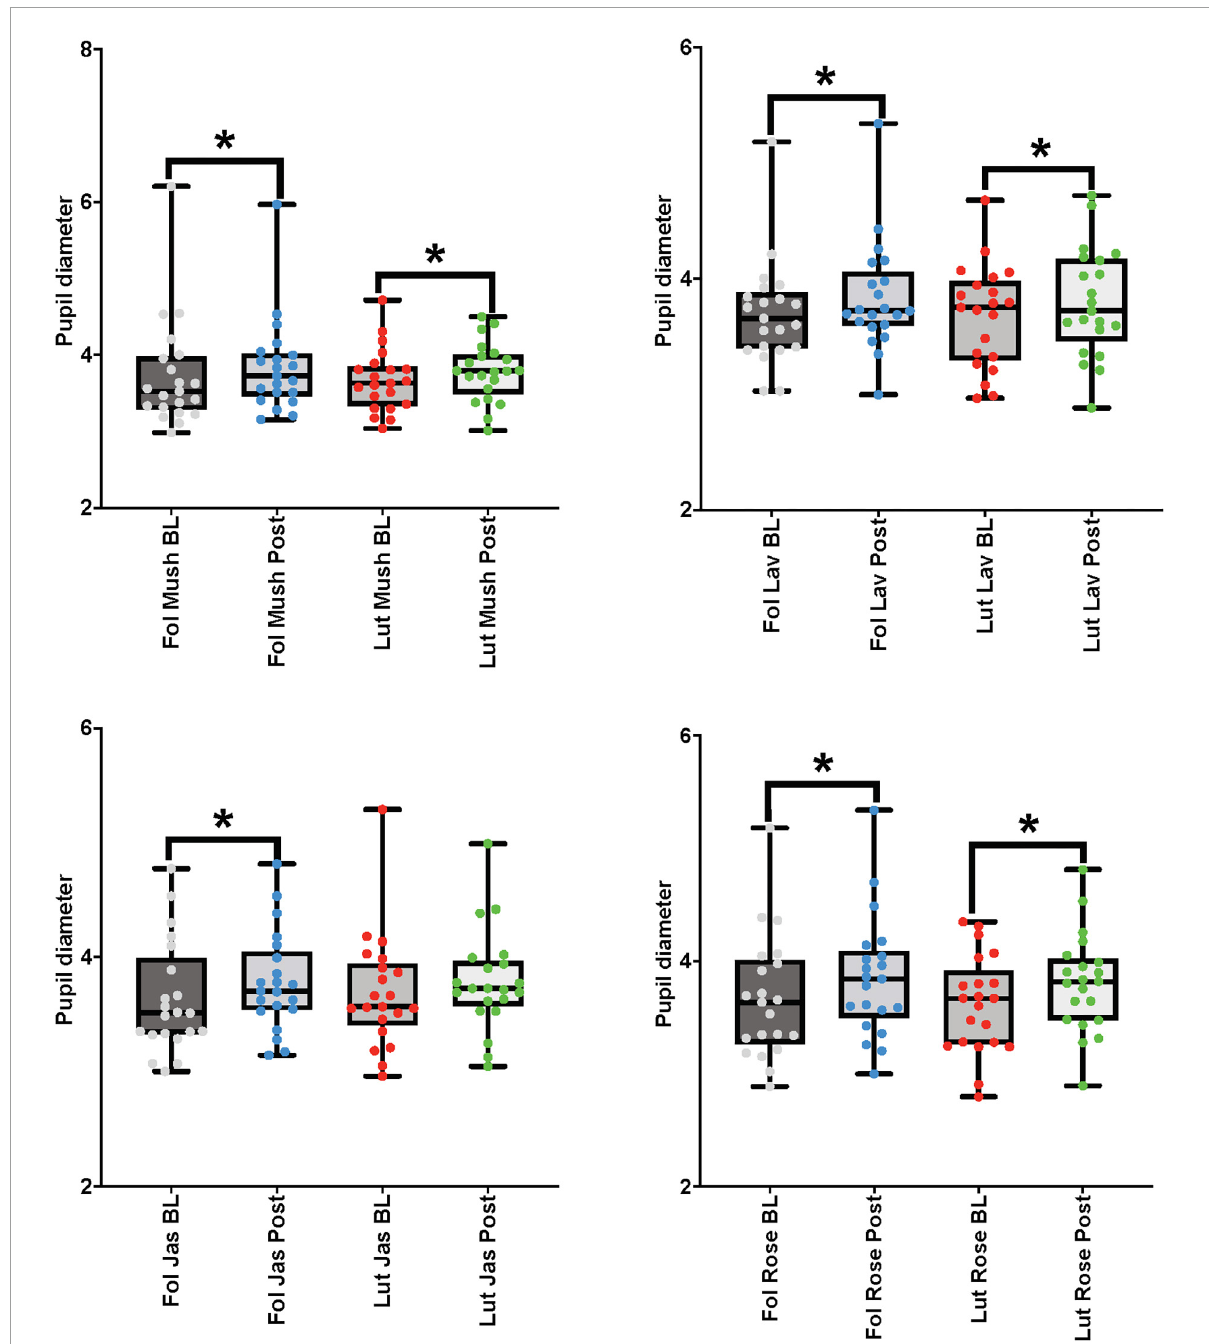
FIGURE6 Eye-tracker (pupil diameter) results from the baseline (BL) and post-stimulation (Post) periods comparisons for all odors (Mush, mushroom; Lav, lavender; Jas, jasmine; Rose, rose) in all four concentrations (sham stimulation, low, moderate, and high concentrations) for the eye-tracker (pupil diameter) for the female cohort in both stages of the menstrual cycle (follicular-Fol and luteal-Lut). * p -value <